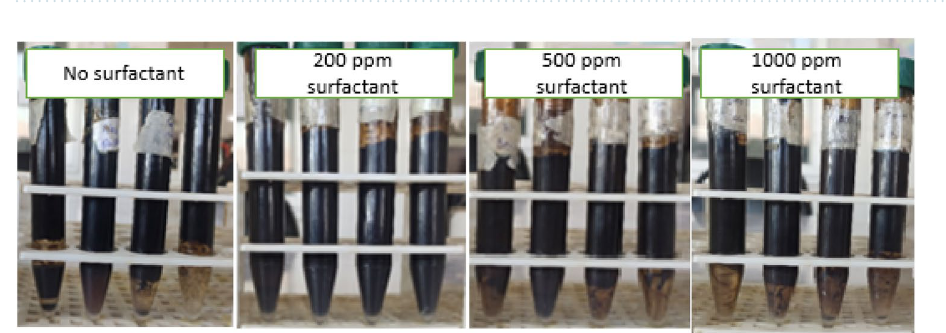
Figure 10. Phase separation after 30 days (0%, 0.1%, 0.3%, 0.5% (w/w) concentration of nanoparticle and 10,000 ppm concentration of MgCl 2 from left to right in each